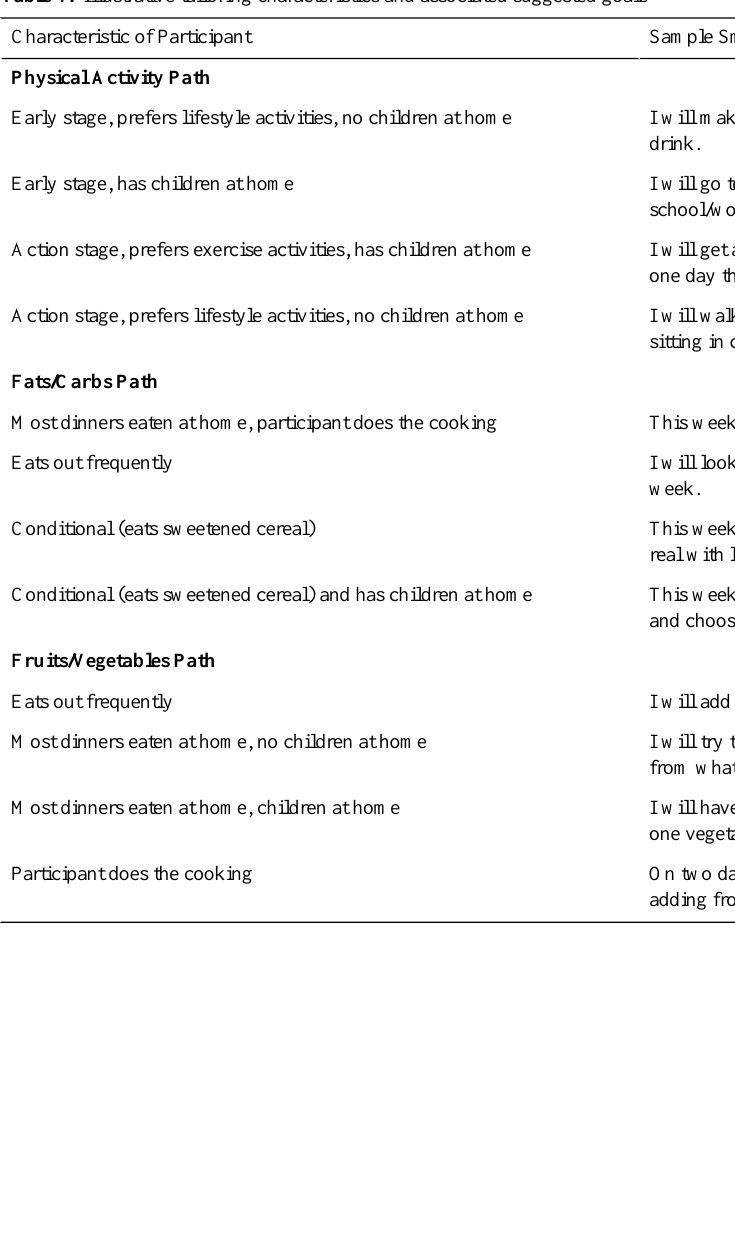
Table 1. Illustrative tailoring characteristics and associated suggested goals